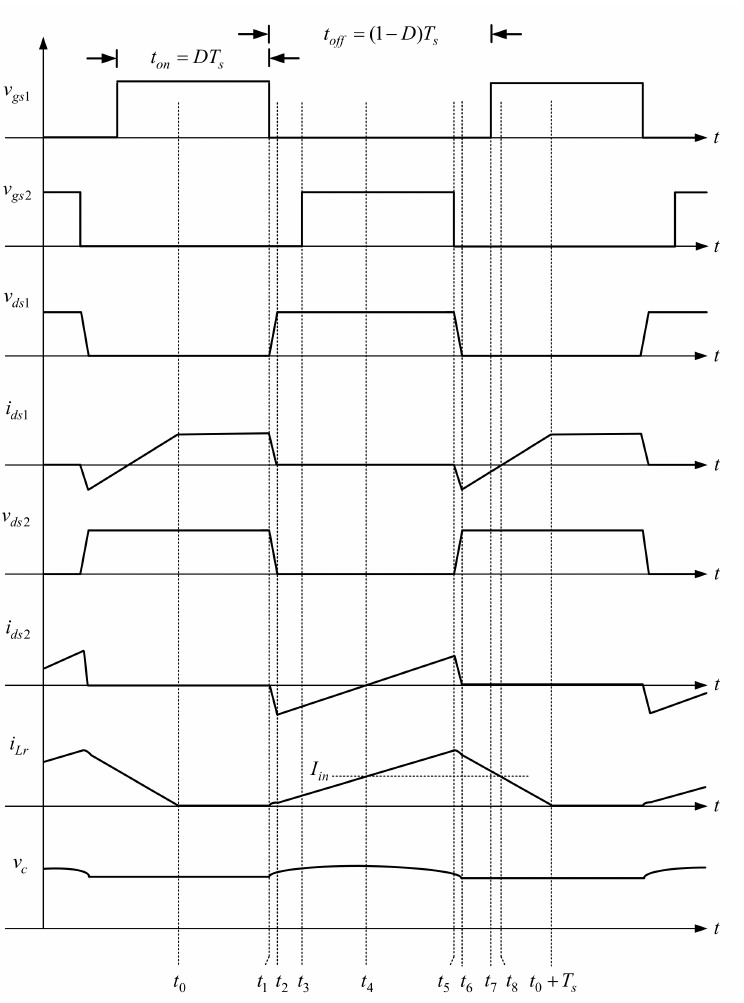
Figure 3. Key waveforms pertaining to the working